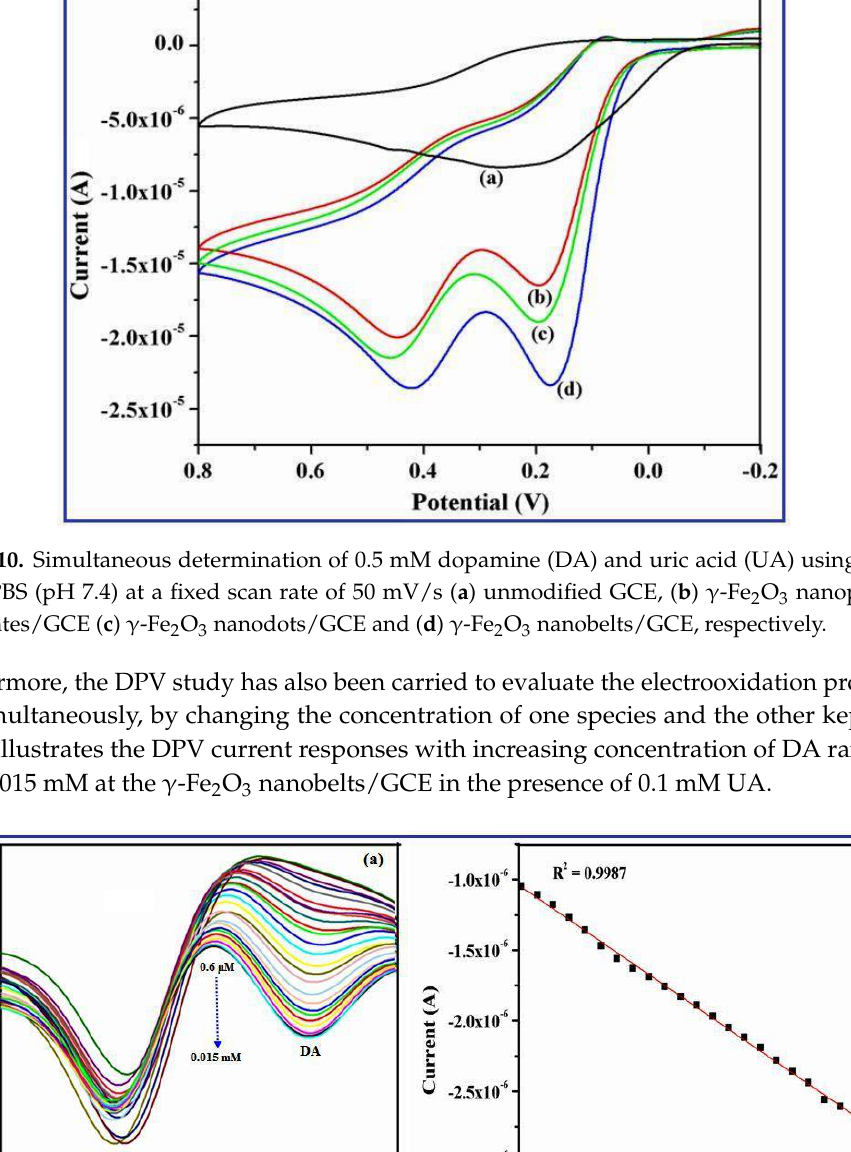
Figure 10. Simultaneous determination of 0.5 mM dopamine (DA) and uric acid (UA) using CV in 0.1 M PBS (pH 7.4) at a fixed scan rate of 50 mV/s ( a ) unmodified GCE, ( b ) γ-Fe 2 O 3 nanoparticle aggregates/GCE ( c ) γ-Fe 2 O 3 nanodots/GCE and ( d ) γ-Fe 2 O 3 nanobelts/GCE, respectively.